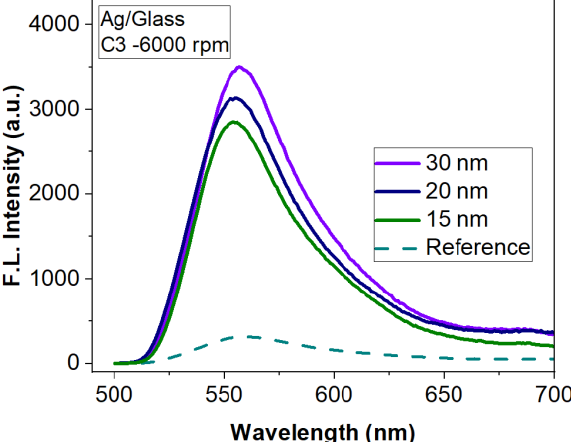
Figure 13. Influence of Ag metasurfaces/glass substrate on FLEN.